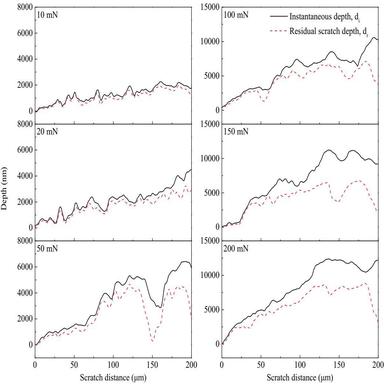
Instantaneous and residual depth profiles of the LIL scratches with different pre-designed loading levels: 10, 20, 50, 100, 150 and 200 mN.